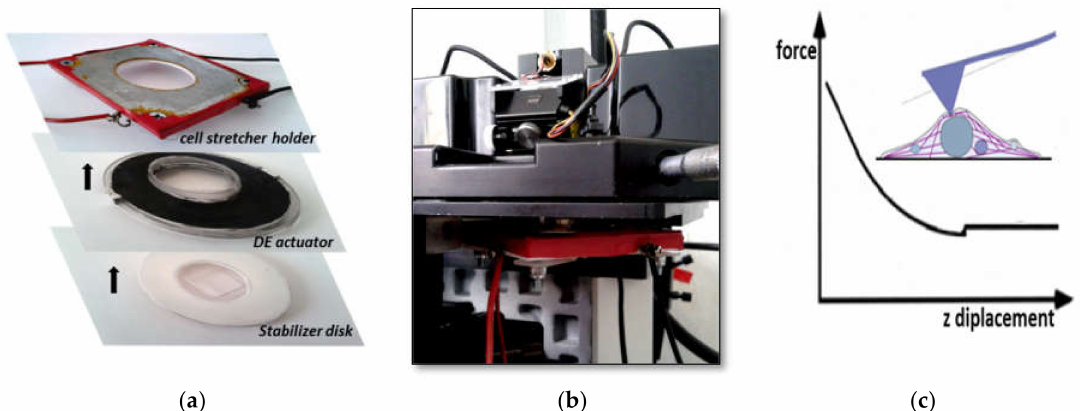
Figure 3. AFM-cell stretcher device system. ( a ) Pictures showing the different components of the cell stretcher device: the VHB film with the annular electrodes and the PDMS ring glued on the upper side delimiting the cell culture chamber (image in the middle). This is clamped in between the metallic holder that magnetically sticks to the AFM head (top image) and the stabilizer disk with the glass window in the center (bottom image). ( b ) Image of the cell stretcher device and the AFM head containing the probe and the scanner on top of the holder. ( c ) Schematics of the AFM tip indenting a cell and characteristic force-displacement curve (only the unloading part of the curve is